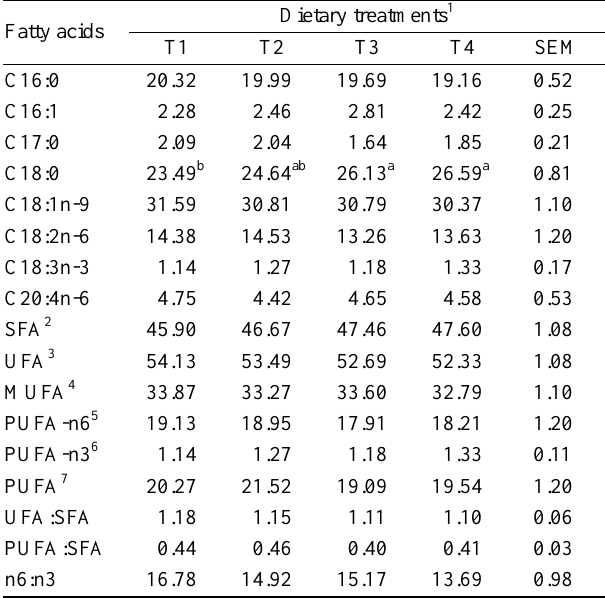
Table 2. Serum fatty acid composition (% of total identified fatty acids) in goats fed experimental diets Fatty